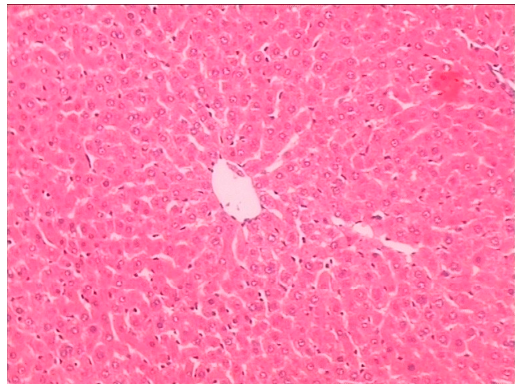
Figure 2. Hematoxylin and eosin (HE)-stained histological sections of rat liver in the control group (Magnification: ˆ 400).